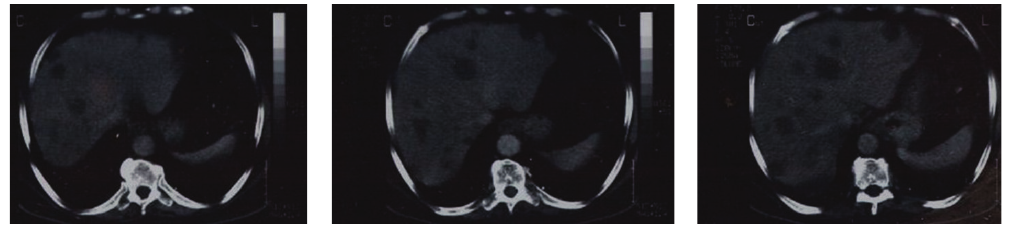
Figure 1: Abdominal CT-scan showing multiple hypodense nodules in both liver lobes.